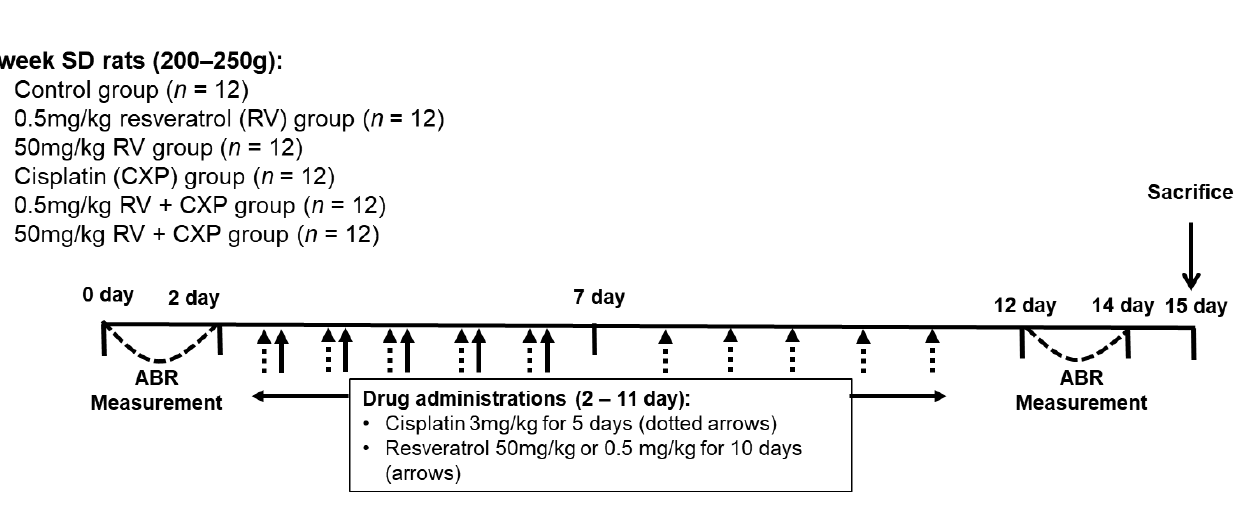
Figure 6. The experimental schedule of the present study. The cisplatin (CXP) group was administered CXP (3 mg/kg/day) for 5 days and then normal saline every day for 5 days. The RV + CXP groups were administered RV along with CXP every day for 5 days and then RV every day for 5 days.